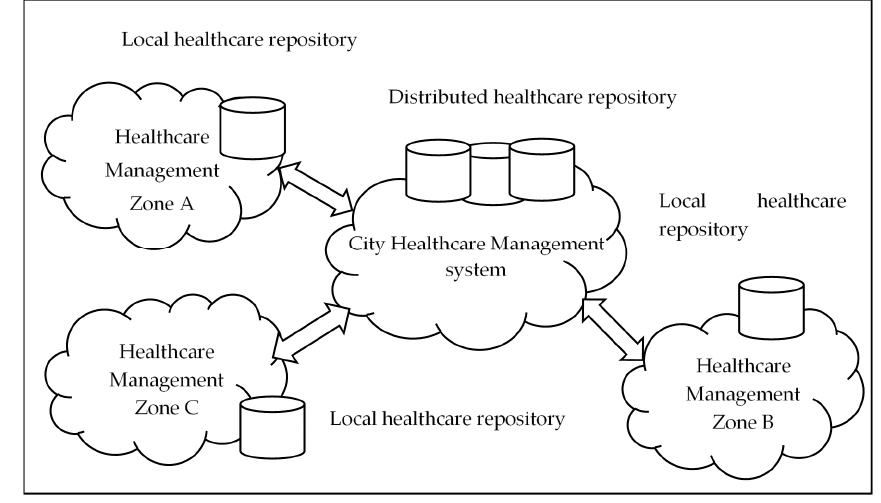
Figure 4. Smart city healthcare architecture .